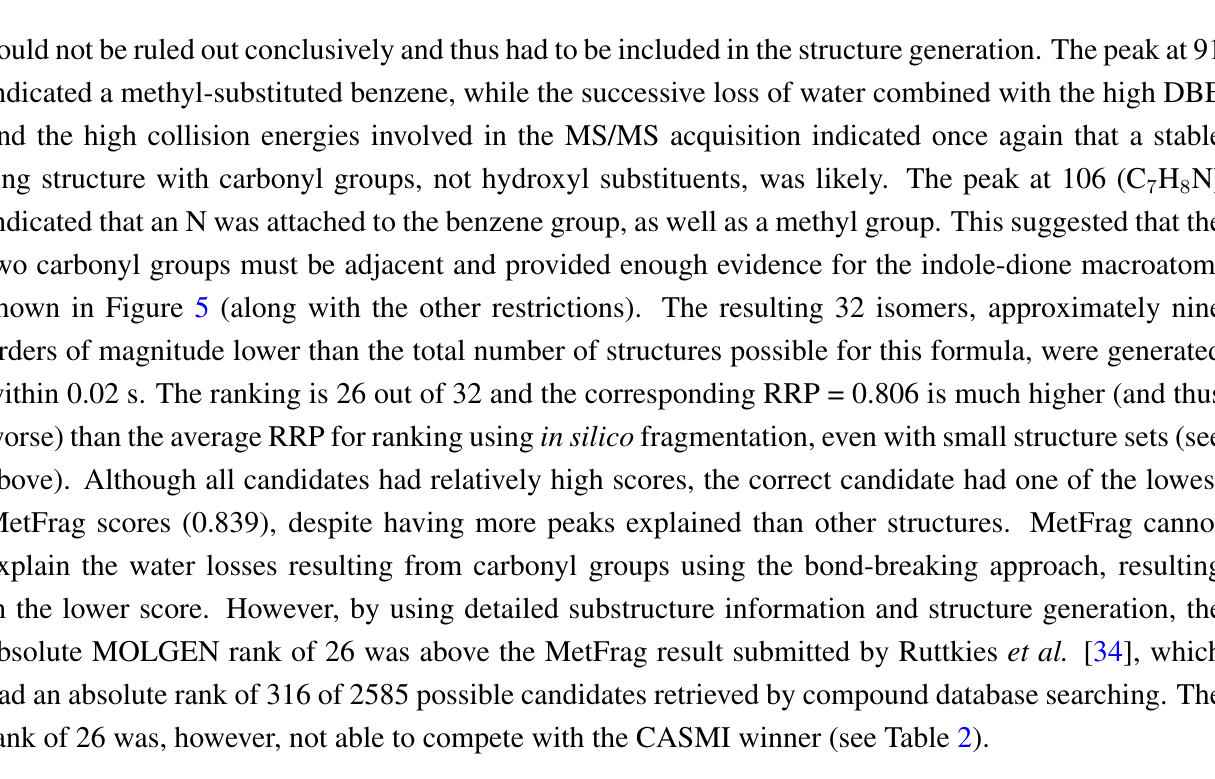
Figure 5. Substructures for Challenge 15. Letters to the bottom left indicate (M) macroatom; (GL) good list; brackets enclose those considered as “or”. FV = free